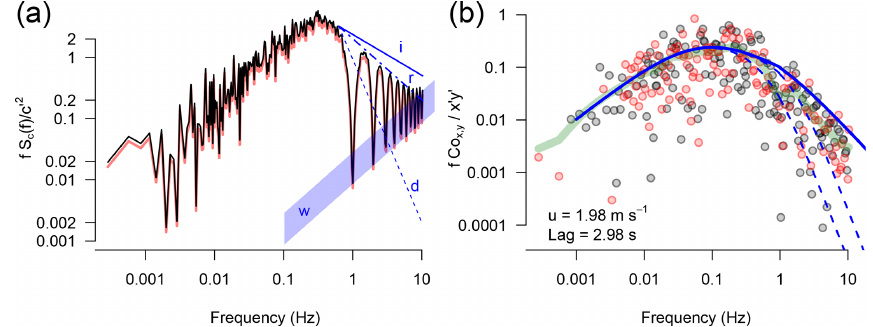
Figure 4. Panel (a) shows an example spectrum of Hg 0 fluctuation measurements, and panel (b) displays a cospectrum of the 1h averaged Hg 0 flux on 31 August 2018 from 14:00 to 15:00. (a) The power spectrum before (red line) and after (black line) detrending is shown, and the theoretical slopes in the inertial subrange are shown for ideal conditions (i, solid line, f − 2 / 3 slope), for a rectangular oversampling at frequencies greater than 1Hz (r, broken line, f − 1 slope) and for a first-order damped spectrum (d, dashed line, f − 8 / 3 slope). The approximated white noise level is shown using a color band (w, f + 1 slope). (b) The flux cospectrum shows the absolute values of the cospectral densities, with black symbols denoting positive contributions to w (cid:48) χ (cid:48) and red symbols denoting negative contributions. The light green bold line is a local polynomial regression fit to the data points, and the blue line denotes an idealized cospectrum. The two dashed blue lines show damped cospectra with respective damping constants of 0.1 and 0.3s.